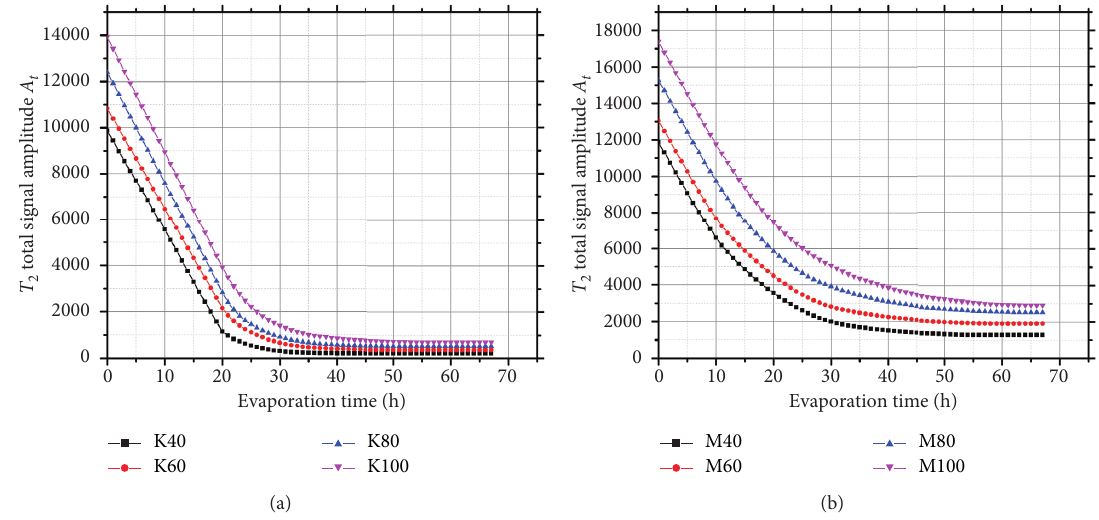
Figure 5: Variation of the total T 2 signal amplitude with respect to evaporation time: (a) K-group and (b)